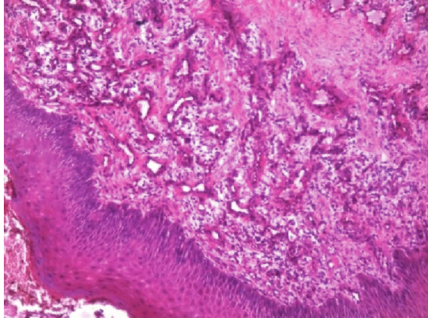
Figure 11: Histopathological view of